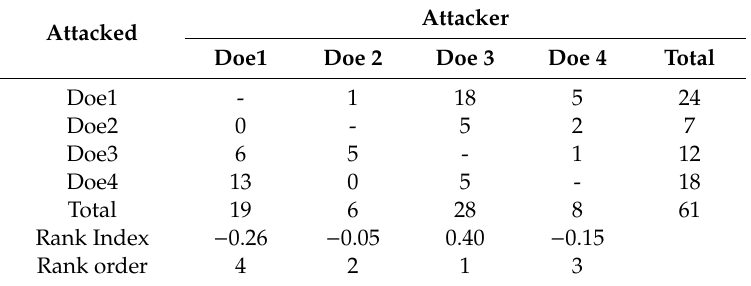
Table 2. Dominance rank order based on the number of fights among the does (HOM2).